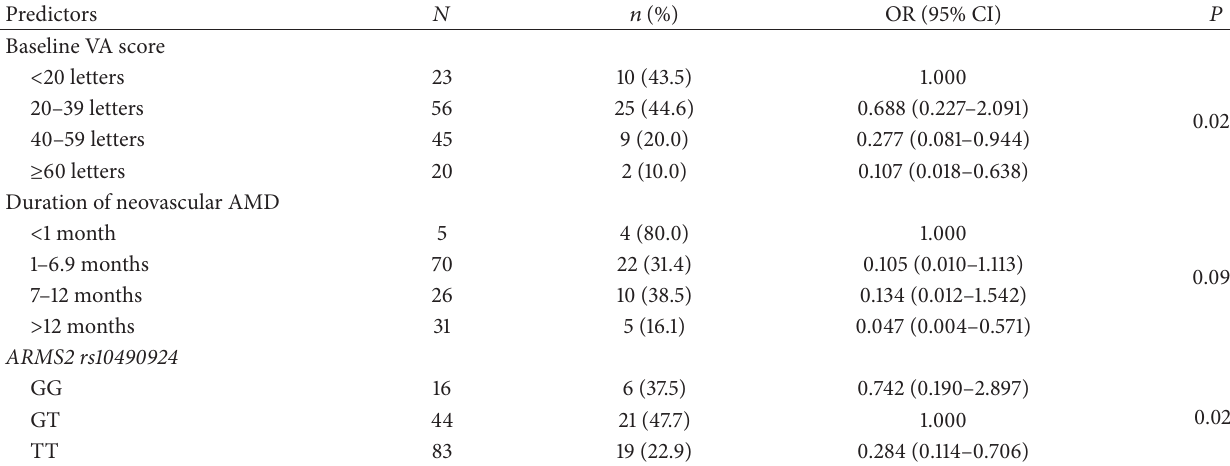
Table 5: Multivariate analysis of ≥ 15 letters gain from baseline at 6